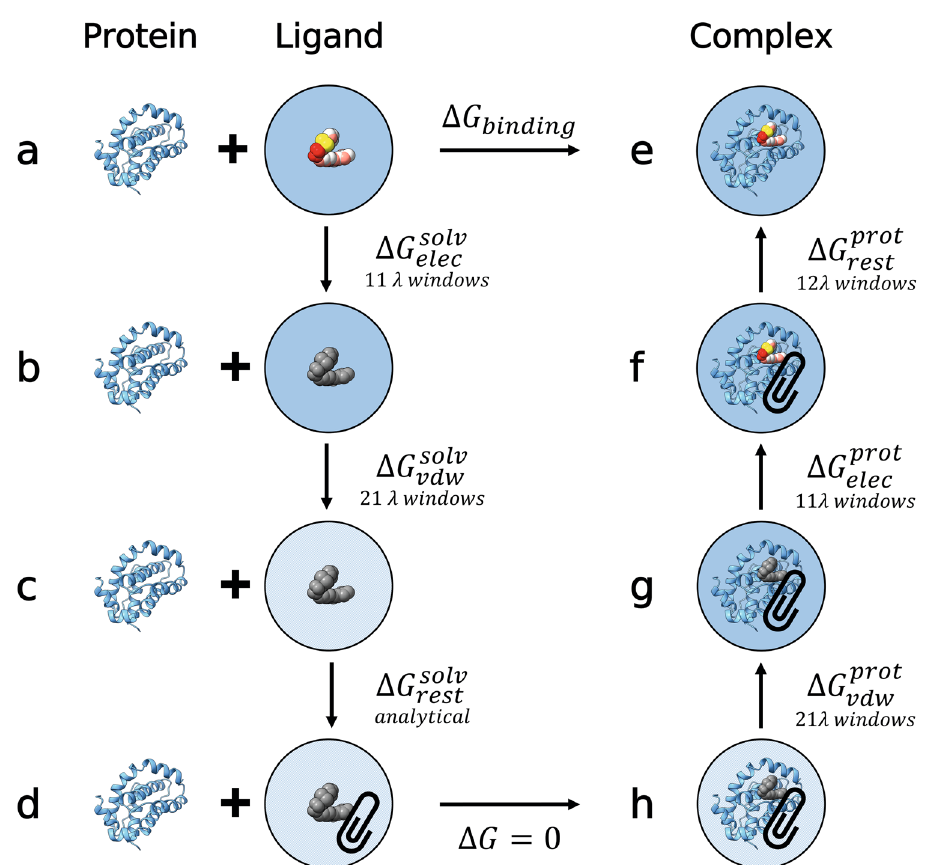
Fig. 2 Absolute binding free energy thermodynamic cycle employed. The free energy of binding, i.e. going from a ligand in solution (state a ) to a protein- ligand complex (state e ), is captured through a non-physical path. First, the electrostatics are annihilated to zero (state b ) over 11 λ windows. This is followed by a further 21 λ windows which decouple the ligand van der Waals interaction from the solvent (state c ). The decoupled ligand is then analytically restrained as de fi ned by ref. 102 (state d ). By accounting for this restraint the ligand state is then equivalent to a non-interacting ligand in a protein-ligand complex (state h ). The ligand interactions with the environment are then turned back on, fi rst re-coupling the van der Waals interactions over 21 λ windows (state g ), followed by a further 11 λ windows to add back electrostatics (state f ). Finally, the orientational restraints are turned off over 12 λ windows resulting in a fully interacting protein-ligand complex (state e